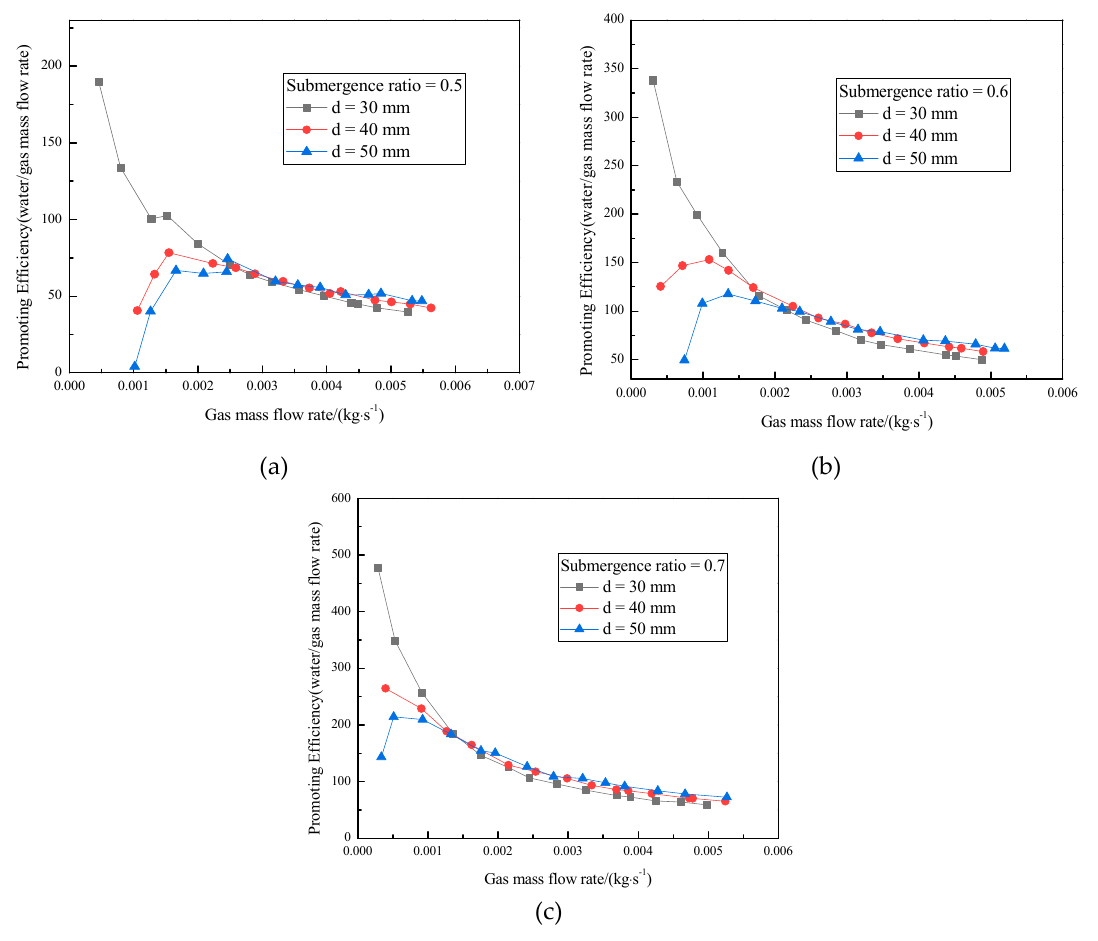
Figure 9. Changes of promoting efficiency with gas flow under different pipe diameters. ( a ) Submergence ratio of 0.5; ( b ) submergence ratio of 0.6; ( c ) submergence ratio of 0.7.